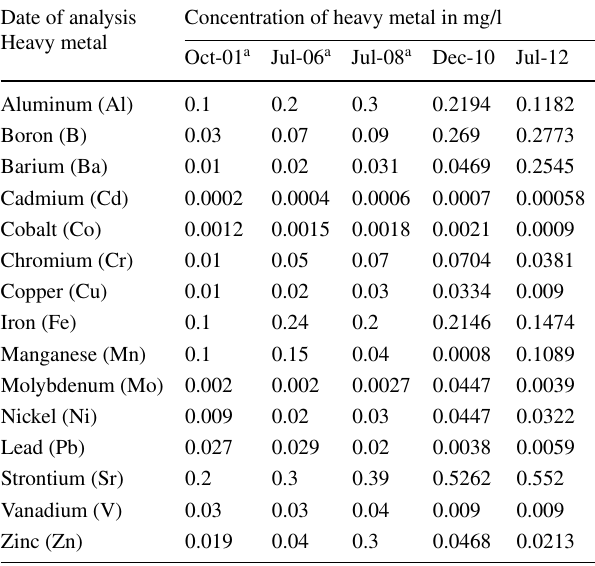
Table 4 Concentration of chemical inorganic pollutants (mg/l) resulted from the analyzed samples of wastewater of pond no.